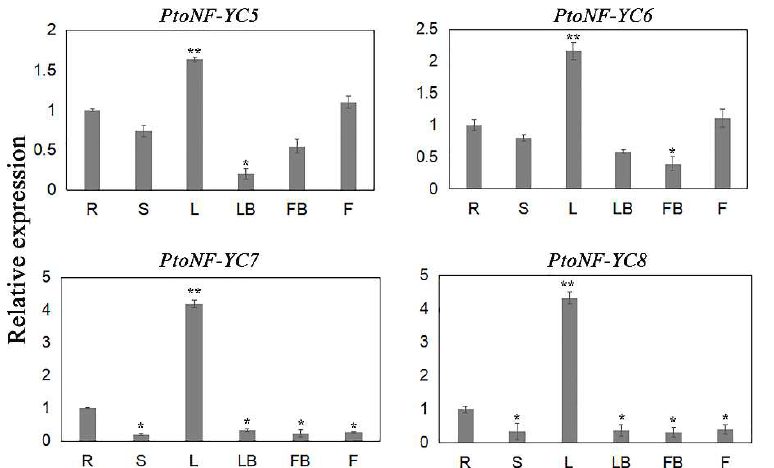
Figure 2. Tissue-specific expression patterns of PtoNF-YC5 / 6 / 7 / 8 in P. tomentosa . R, S, L, LB, FB, and F represent roots, stems, leaves, leaf buds, flower buds, and flowers, respectively. The data was presented as mean ± SE (n = 3 independent replicates), * ( p < 0.05) and ** ( p < 0.01) indicate significant differences.